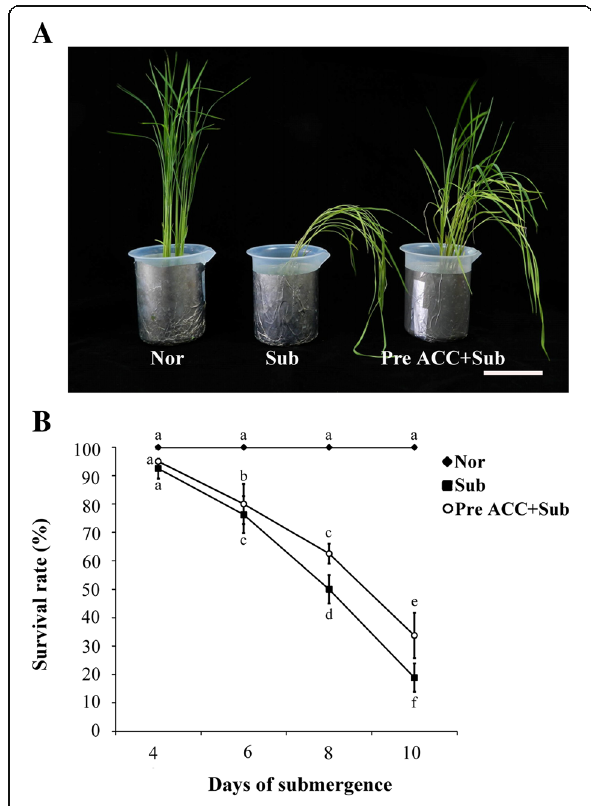
Fig. 2 Tolerance determination of rice seedlings under submergence by pretreatment with an ethylene precursor. a The phenotypes of 8-day-old TK9 rice seedlings treated under Nor, Sub, and Pre ACC + Sub for 2days and then subjected to submergence for 10days and subsequent recovery for 10days. Bar=1cm. The photograph exhibits the results in three independent seedlings. b The survival rate of TK9 rice seedlings treated under Nor, Sub, and Pre ACC +Sub for 2days and then subjected to submergence for 4, 6, 8, and 10days followed by 10-day recovery. The data represent the average values ± SD from 30 seedlings of each treatment obtained from three biologically independent experiments. The values with different letters are significantly different at P <0.05, according to one-way ANOVA with